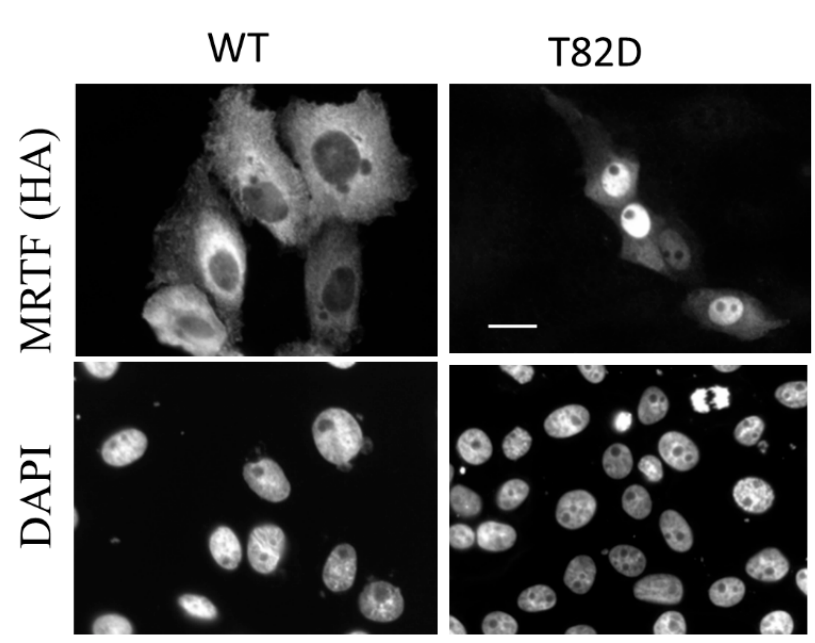
Figure 3. Phosphomimetic mutation of a potential ROK target site induces nuclear localization of MRTF. LLC-K1 proximal tubular cells were transfected with Hemagglutinin (HA)-tagged WT or T82D mutant MRTF-B constructs. Cells were stained for the HA epitope and nuclear marker, DAPI. Note that WT MRTF is cytosolic whereas the T82D mutant shows robust nuclear accumulation. Bar: 20 µm. (P. Speight and & A. Kapus, unpublished).